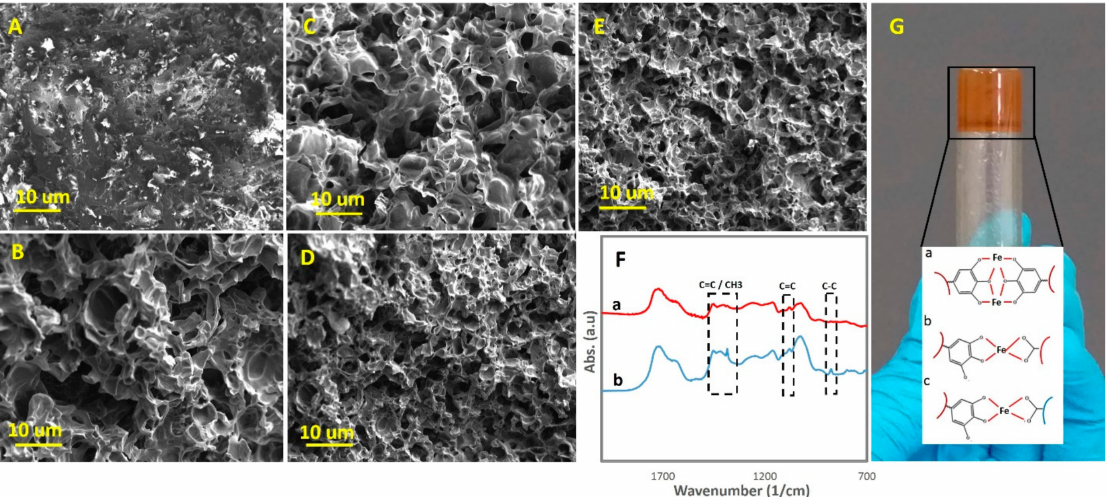
Figure 2. SEM images of ( A ) unreinforced hydrogel, ( B ) PVA-St-PAA-Fe/TA@ChNF0.5 ( C ), PVA-St-PAA-Fe/TA@ChNF1, ( D ) PVA-St-PAA-Fe/TA@ChNF1.5, ( E ) PVA-St-PAA-Fe/TA@ChNF2, ( F ) FTIR results of ( a ) PVA-St-PAA hydrogel and ( b ) and PVA-St-PAA-Fe/TA@ChNF0.5 hydrogel, ( G ) PVA-St-PAA-Fe/TA@ChNF0.5 hydrogel with different modes of dynamic catecholato–metal coordination